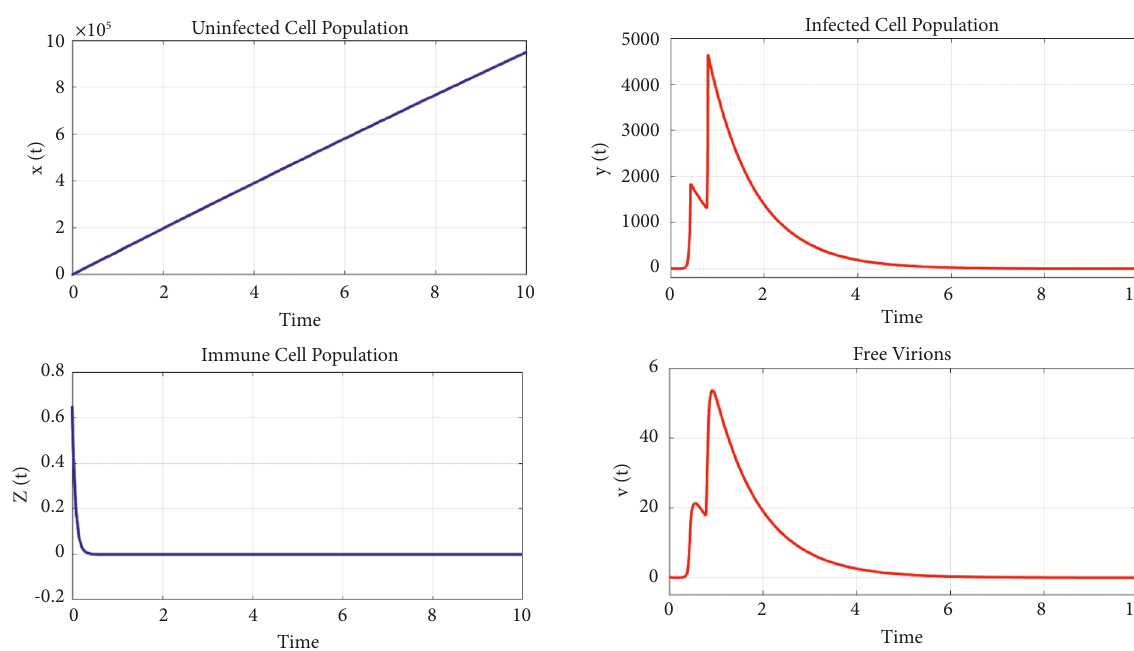
Figure 3: Optimal control-based state responses with respect to